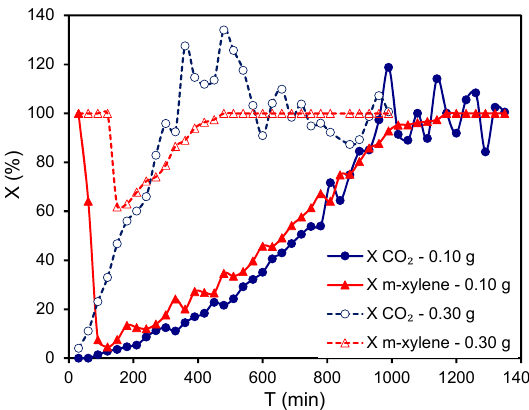
Figure 10. Influence of the contact time on the m -xylene combustion obtained for A1000-Pt at 190 °C ([ m- xylene] = 1500 ppm, Q = 3.6 L h − 1 , 0.10 or 0.30 g catalyst ). Figure adapted with permission from [64]. Copyright 2011,